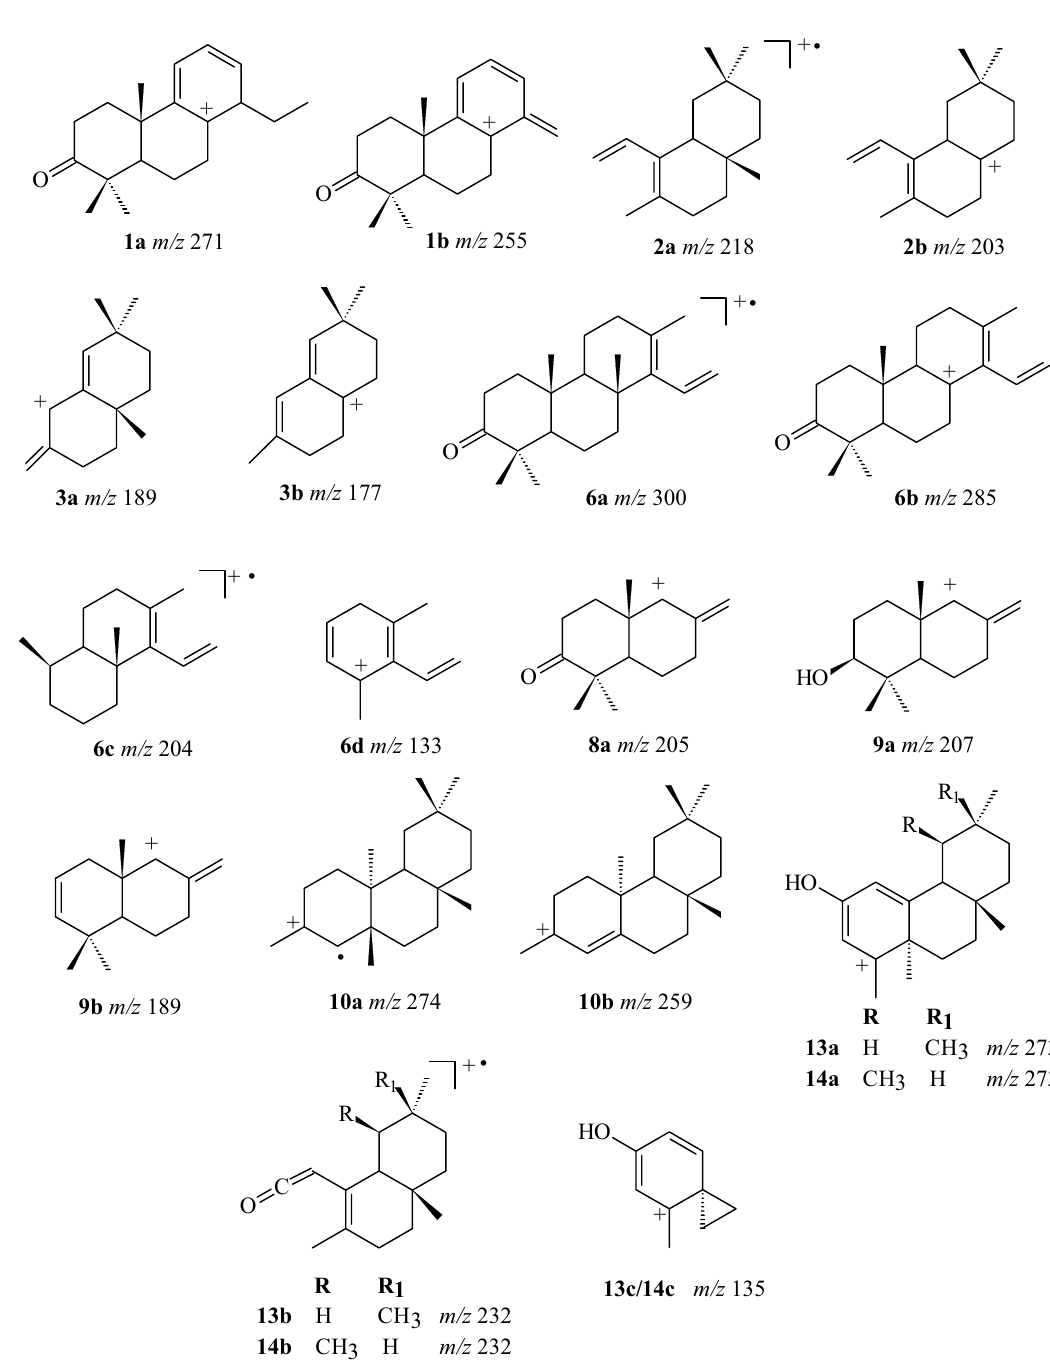
Fig. 4 – Ionic fragments corresponding to principal peaks observed in the mass spectra. Obviously, the ionic fragments that appear with numbers and letters to indicate the triterpene correspondents can be used for other triterpenoids if compatible.